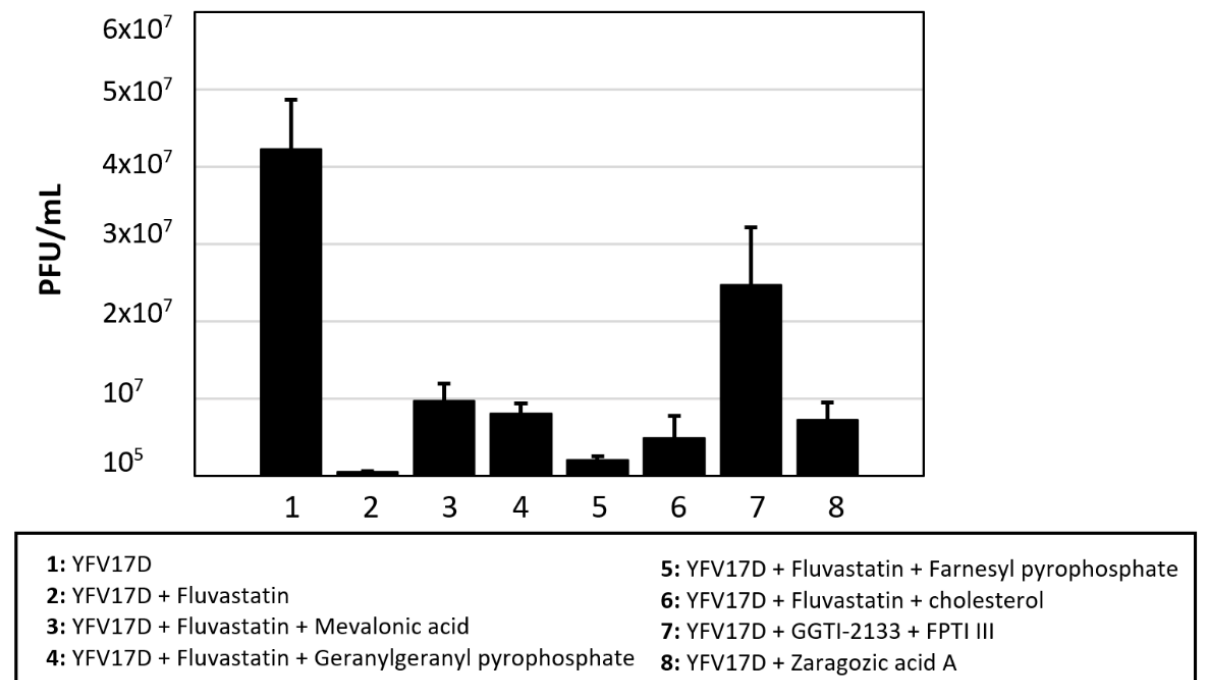
Figure 4. YFV17D-infected BSR cells treated with fluvastatin, inhibitors of geranyl-geranylation (geranyl-geranyl transferase inhibitor GGTI-2133 or farnesyl pyrophosphate transferase inhibitor FTPIII), inhibitors of squalene synthase (zaragozic acid), or treated with fluvastatin then supplemented with components of the mevalonate pathway (mevalonic acid, geranyl-geranyl pyrophosphate, farnesyl pyrophosphate or cholesterol) in attempts to restore virus replication in fluvastatin-treated cells. These results are representative of four distinct experiments. Error bars with standard deviations are shown.